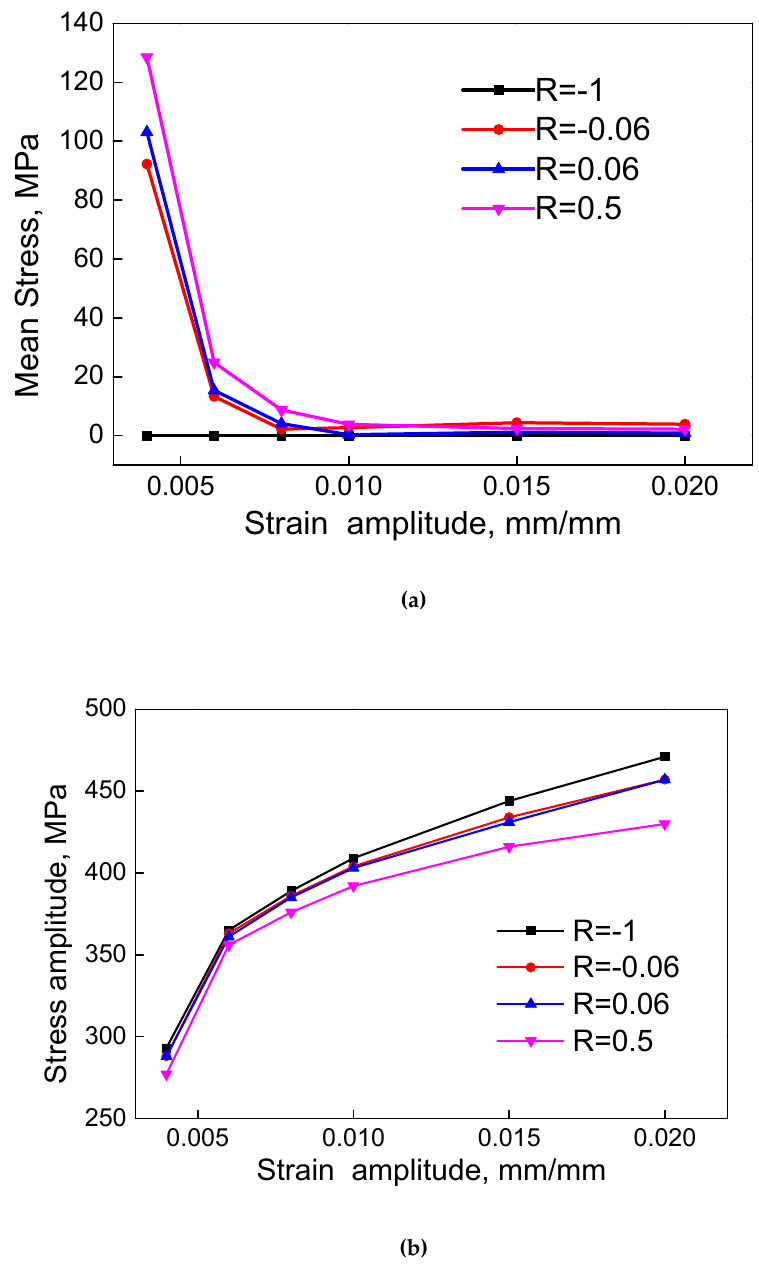
Figure 1. Comparisons on ( a ) mean stress and ( b ) stress amplitude of 2124-T851 aluminum alloy under different strain ratios, R .